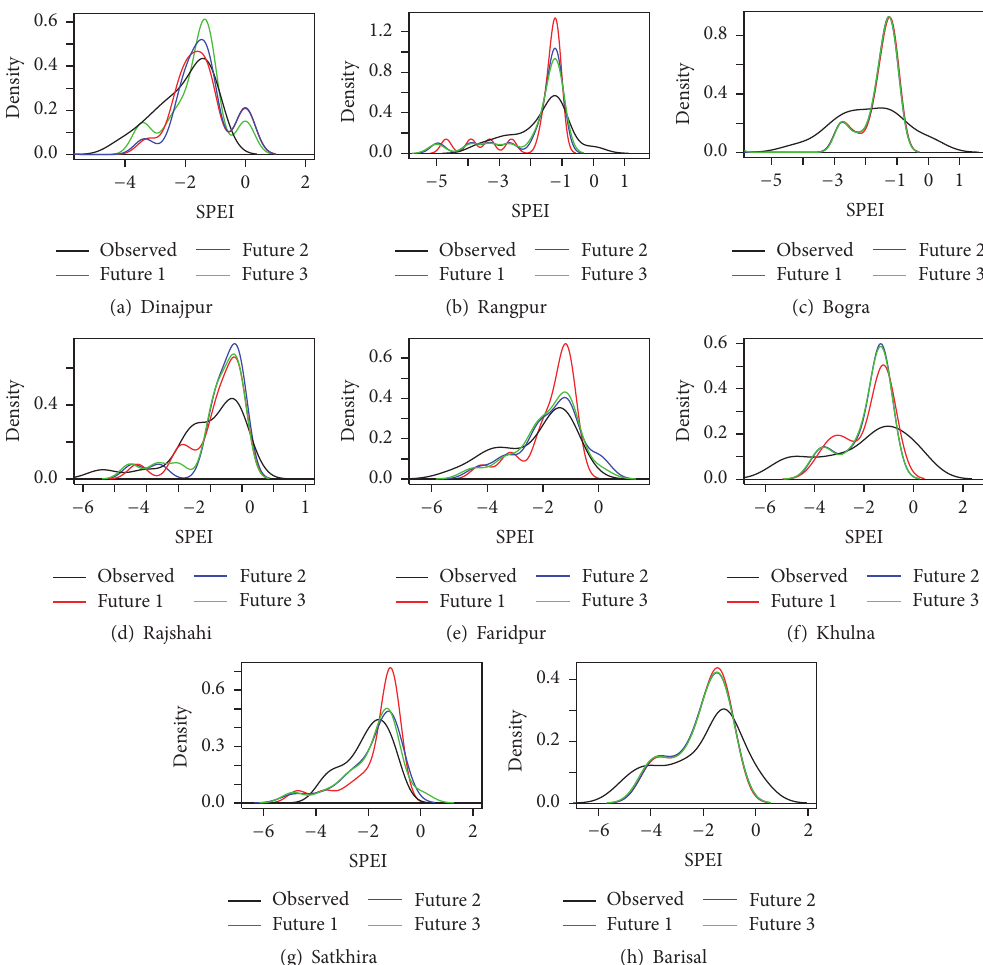
Figure 6: The probability density function (PDF) of SPEI values by the threshold level during January to May for the A1B scenario using the three GCMs outputs in the northwestern and southwestern regions. The black, red, blue, and green lines represent the PDFs during the observed period (1984–2013), future 1 (CGCM3.1 GCMs), future 2 (FGOALS-G1.0 GCMs), and future 3 (HadGEM1 GCMs) models, respectively, for the period